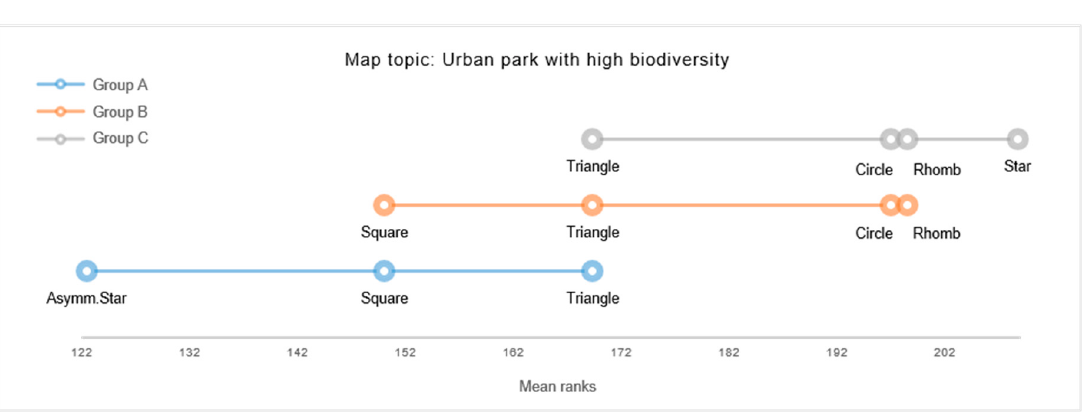
Figure 7. Map #3: Results of multiple pairwise comparisons, indicating groups of (dis)similar symbol-content congruence.